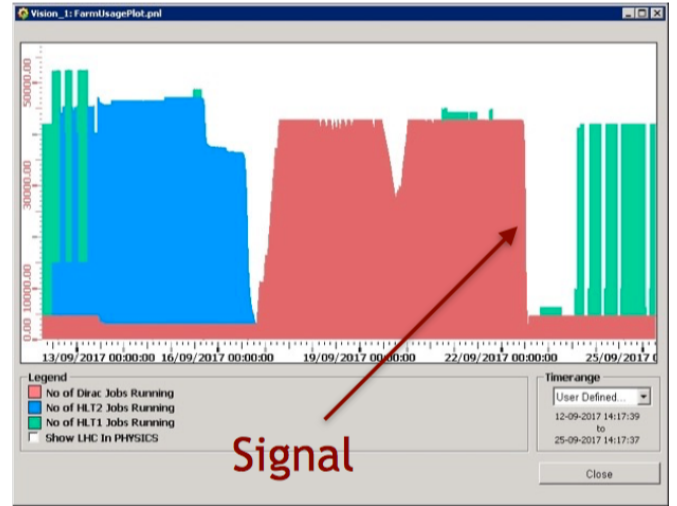
Figure 6. Switch activity in the HLT